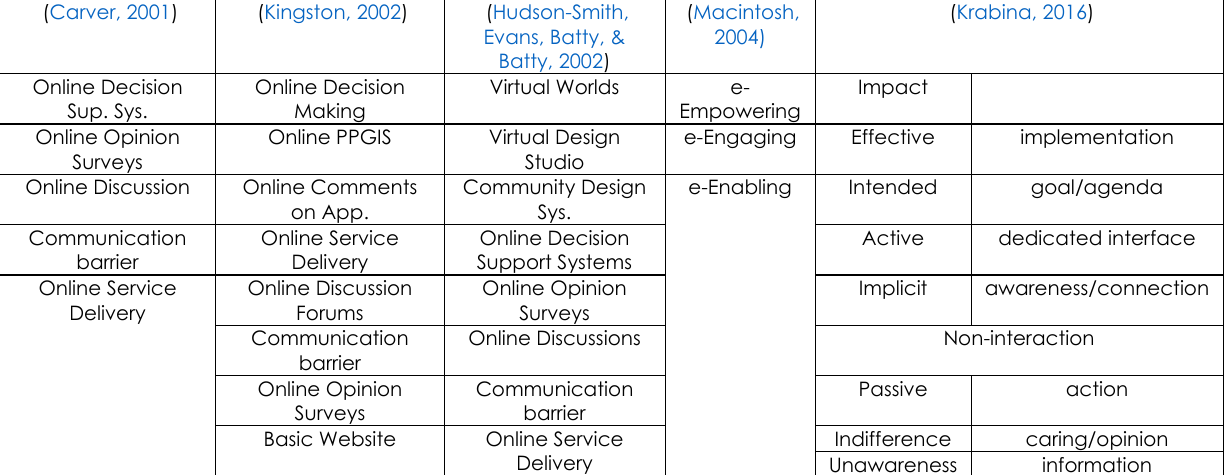
Table 2. Ladder of E-participation Through Different Perspectives.